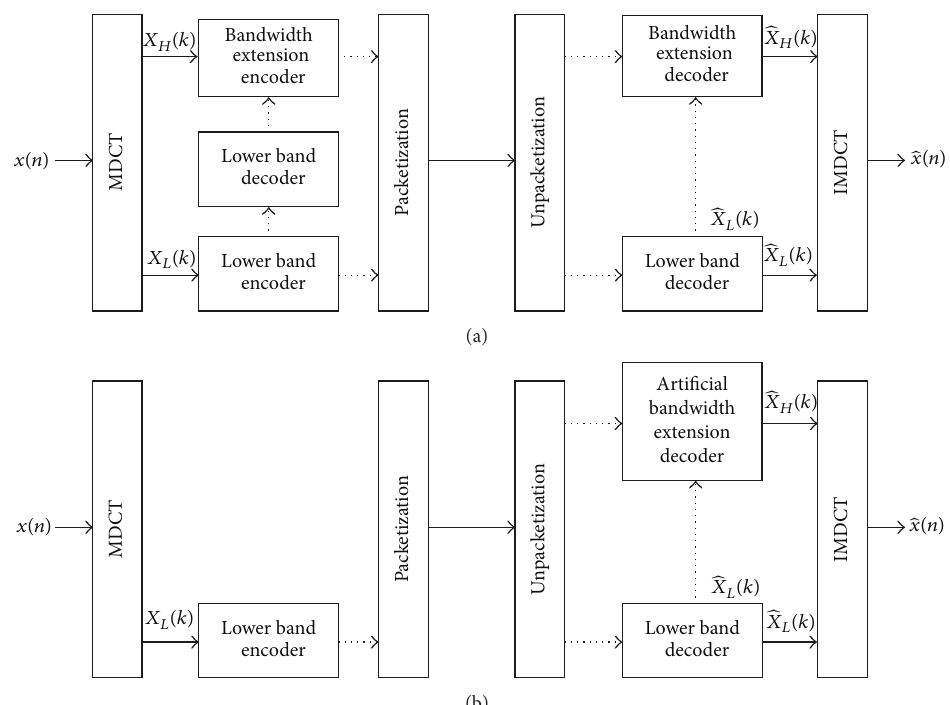
Figure 1: Classification of bandwidth extension algorithms applied in the MDCT domain: (a) bandwidth extension with the side information and (b) without any side information (artificial bandwidth